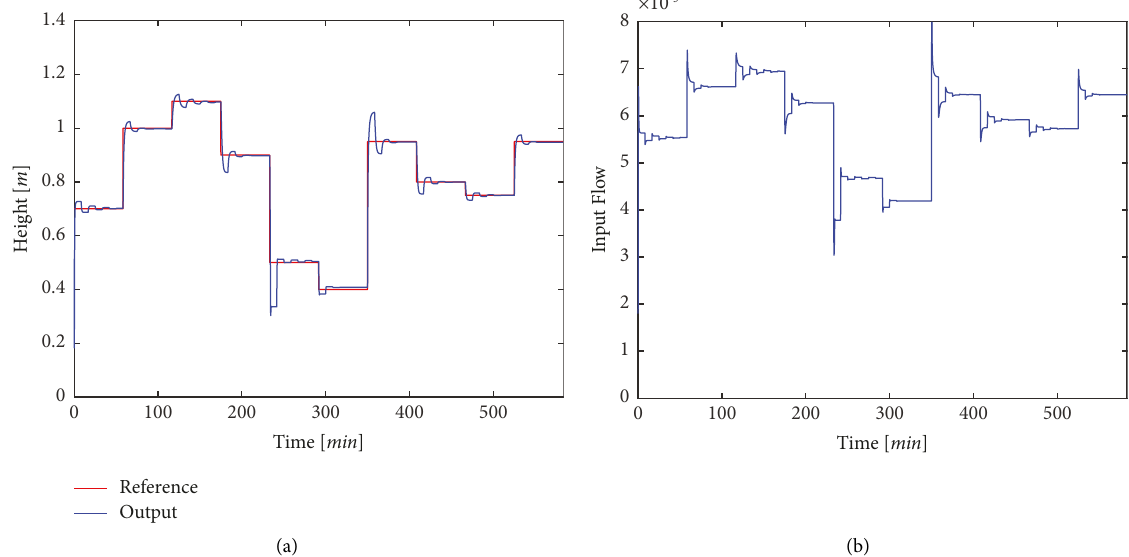
Figure 17: Response of the adaptive control system. (a) Control system output. (b) Input flow to the conical tank.